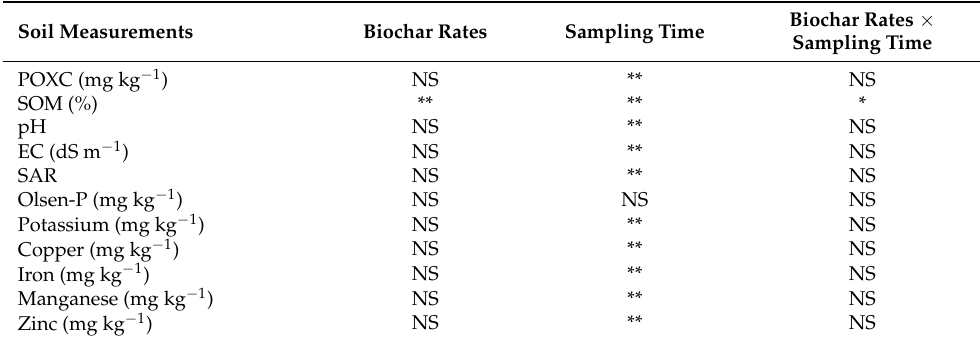
Table 5. Analysis of variance results of the effects of biochar rates, sampling time, and their interaction on measured soil parameters under